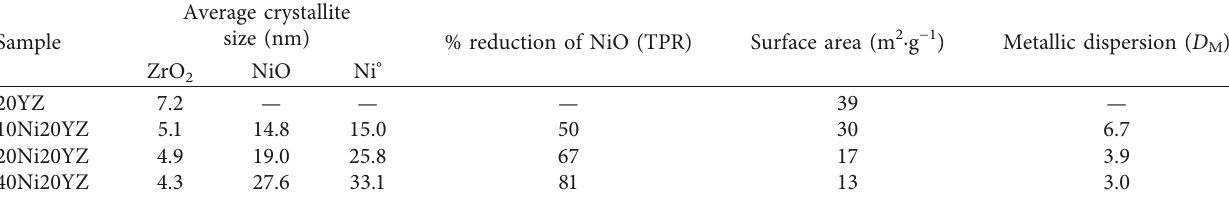
Table 1: Physical-chemical properties of the catalysts and TPR analyses results.